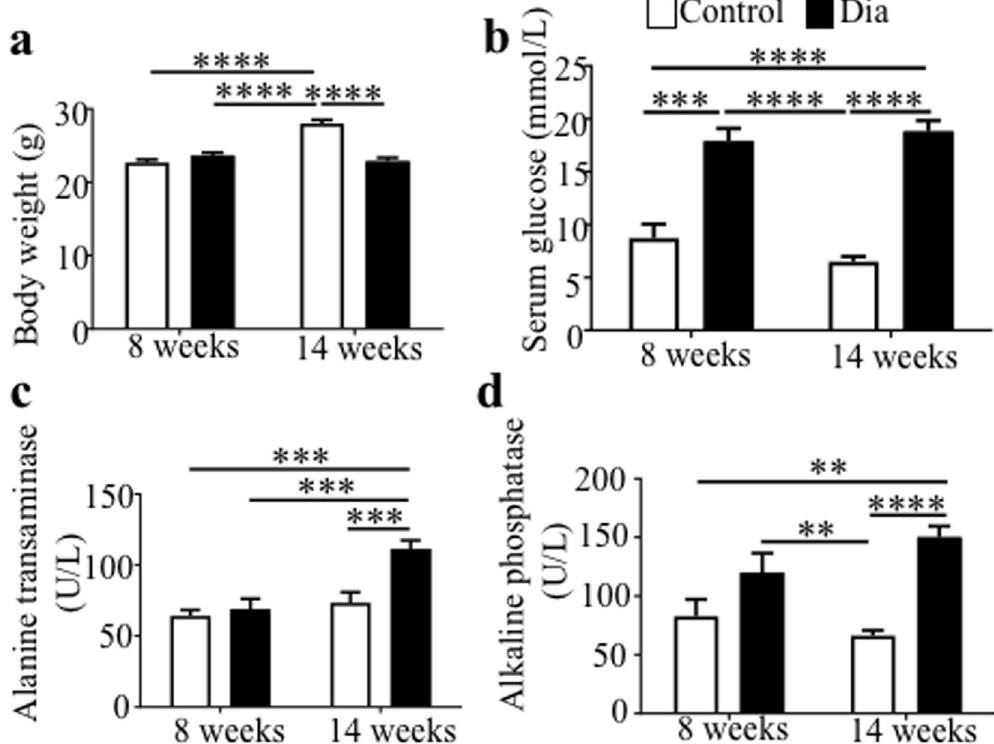
Figure 1. Changes in body weight and serum biochemical characteristics at the start of the experiment (8 weeks of age) and at the end of the experiment (14 weeks of age). The body weight and serum biochemical parameters were measured at the beginning of the study and after 6 weeks of diabetes-exposure. ( a ) body weight and ( b ) serum level of glucose, blood glucose levels maintained above 13.9 mmol/L are classified as diabetic. ( c ) Changes in the serum levels of alanine transaminase and ( d ) alkaline phosphatase. The values represent means ± SEM, (n = 12/group). ** P < 0.01, *** P < 0.001, **** P < 0.0001 compared all pairs by Tukey’s post-